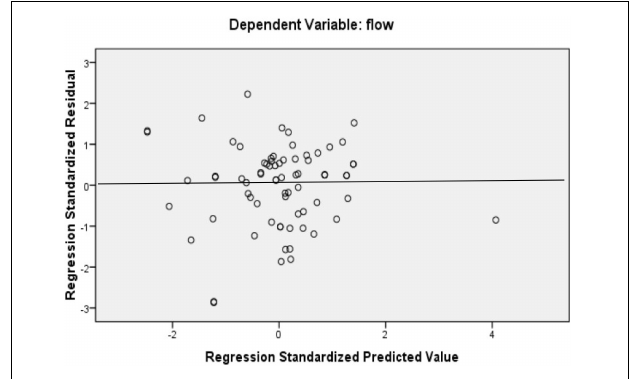
FIGURE 4 | The scatter plot of the